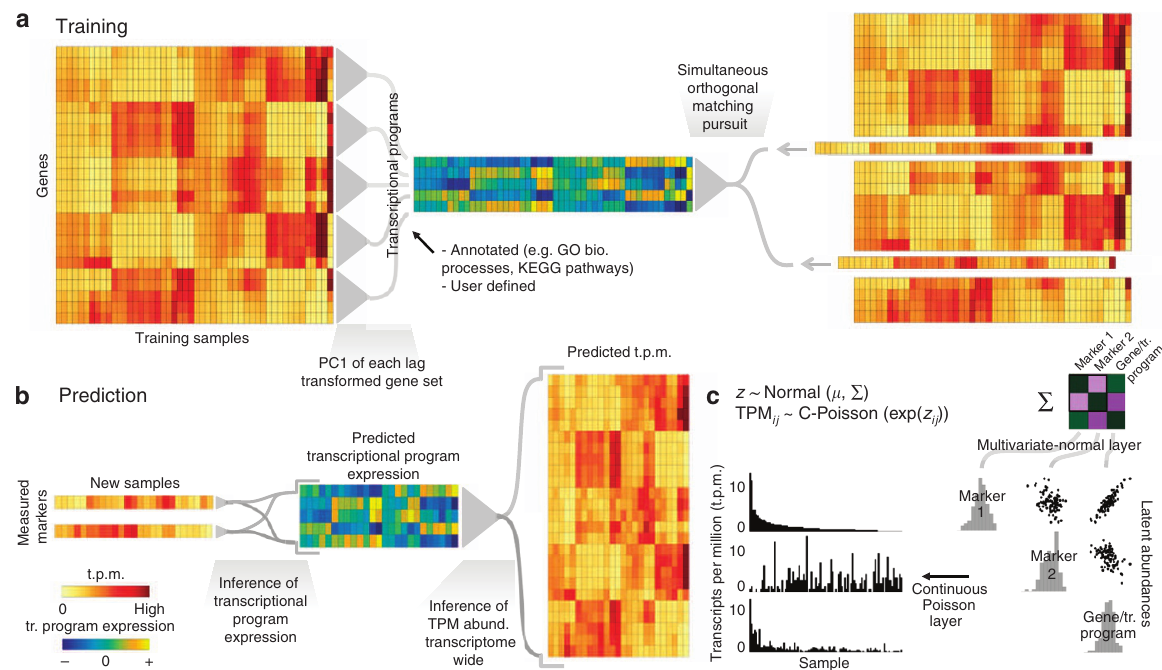
Figure 2 | Tradict’s algorithmic workflow. ( a ) During training, the transcriptome is first quantitatively summarized in terms of a collection of a few hundred, biologically comprehensive transcriptional programs. These are then decomposed into a subset of marker genes using an adaptation of the Simultaneous Orthogonal Matching Pursuit algorithm. A MVN-CP hierarchical model is used as a predictive model to capture covariance relationships between markers, transcriptional programs and all genes. ( b ) During prediction, Tradict predicts the expression of transcriptional programs and all genes in the transcriptome using the expression measurements of the marker genes. ( c ) The MVN-CP hierarchy enables Tradict to efficiently model statistical coupling between the non-negative expression measurements typical of sequencing experiments. This is done by assuming that associated with each observed, noisy t.p.m. measurement, there is an unmeasured (denoised), latent abundance the logarithm of which comes from a MVN distribution over all genes and transcriptional